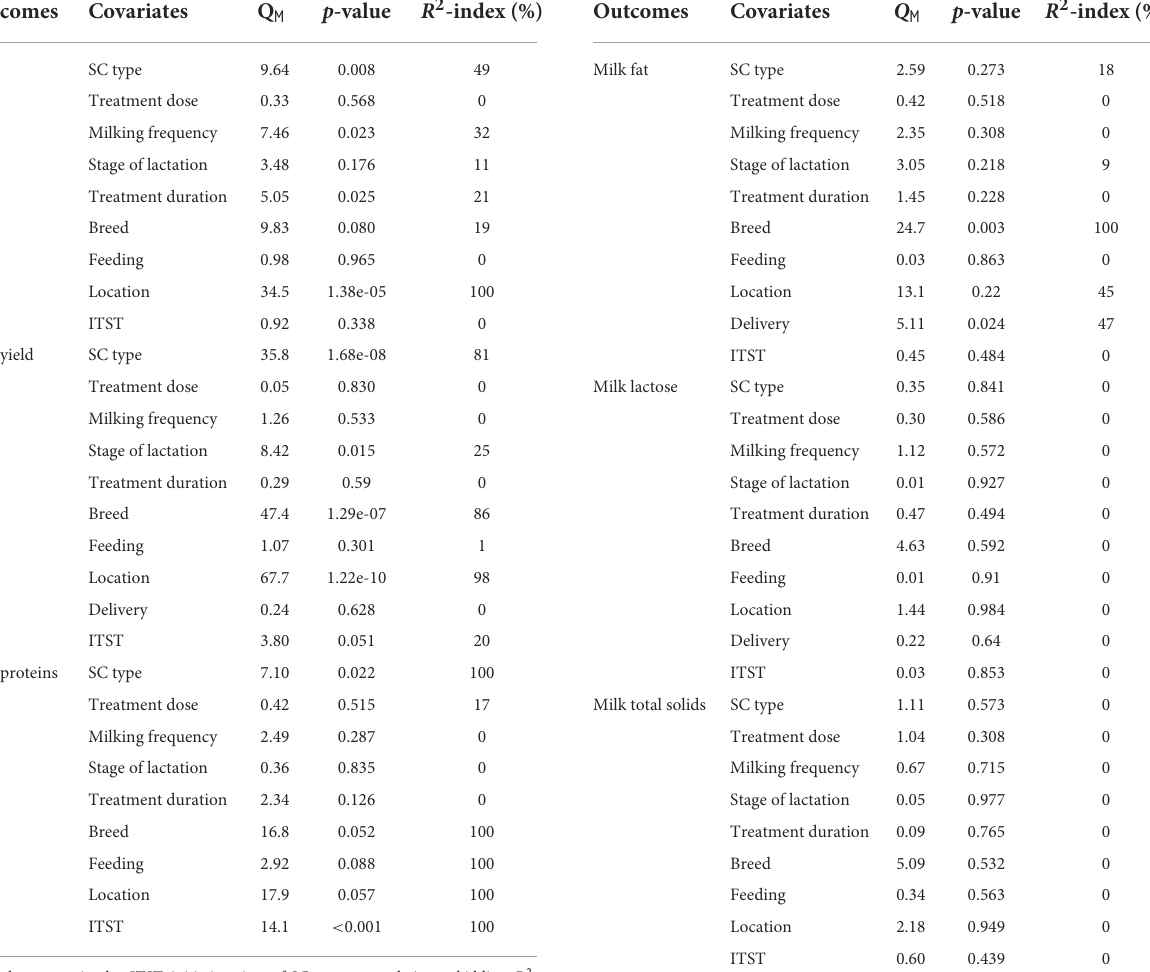
TABLE 6 Relationships between covariates and outcome measures (DMI, milk yield and proteins). Outcomes Covariates Q M p -value R 2 -index (%) DMI